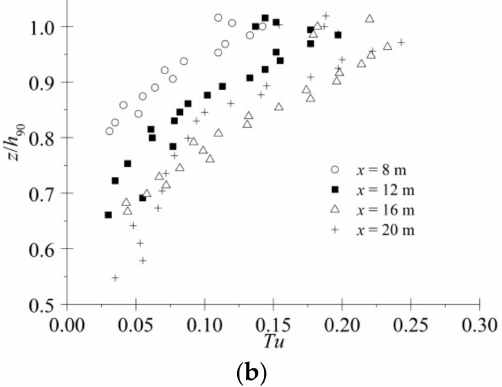
Figure 6. Distributions of air bubble frequency ( a ) and turbulence intensity ( b ). Run: T1–8.